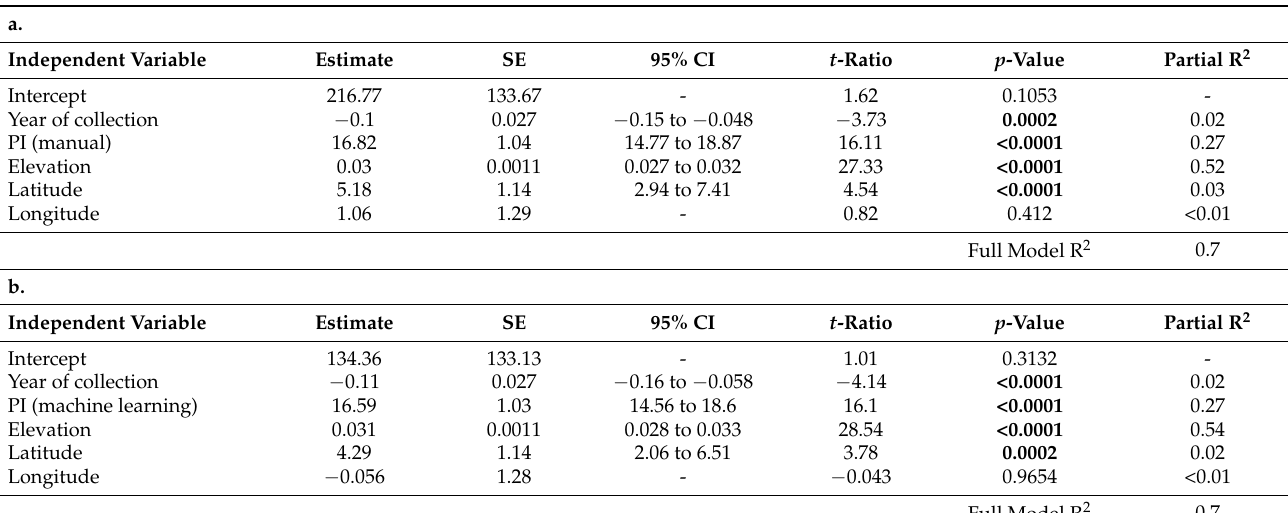
Table 3. Summary of the multiple linear regression designed to detect temporal shifts in flowering date while controlling for the phenological status as estimated by the (a) manually-derived or (b) machine-learning-derived phenological index (PI). Bold values represent significant effects at p < 0.05.